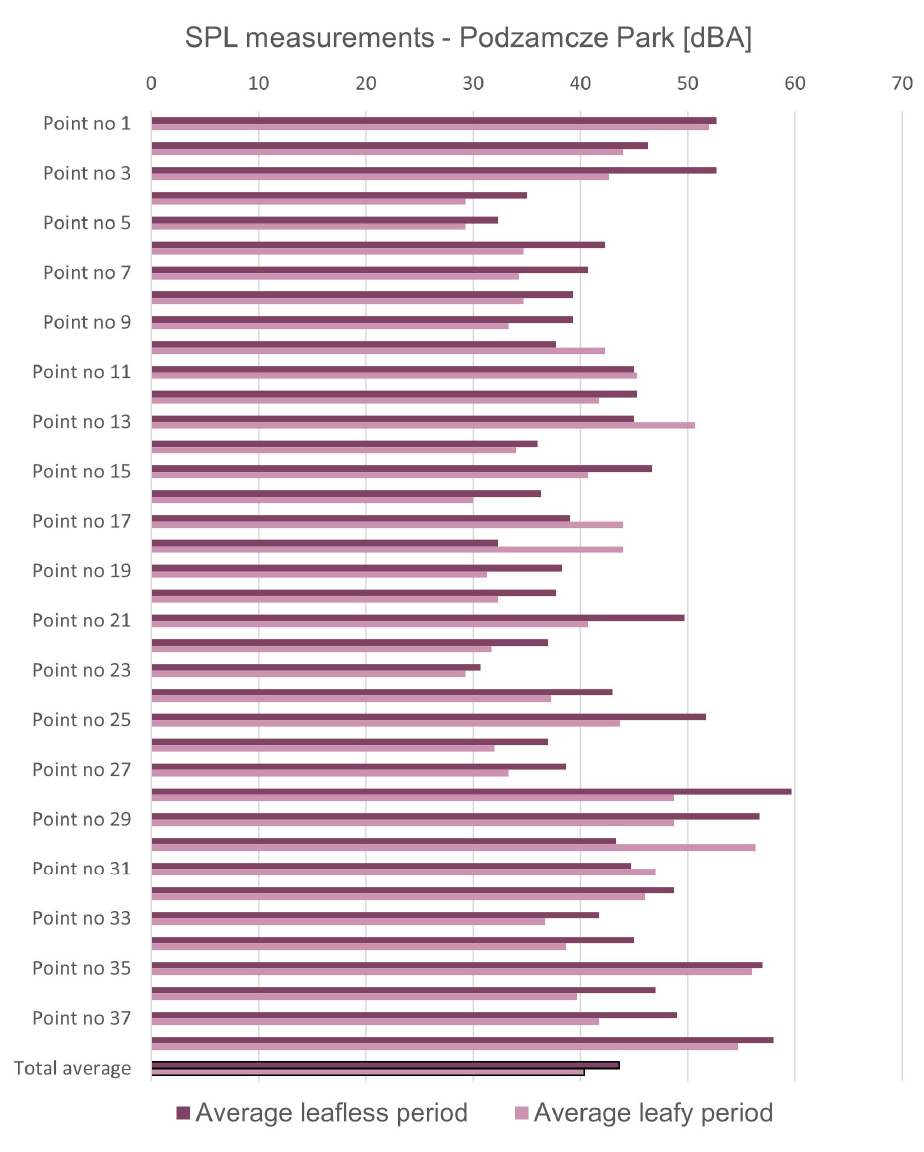
Figure 14. SPL measurements dBA—Podzamcze Park.